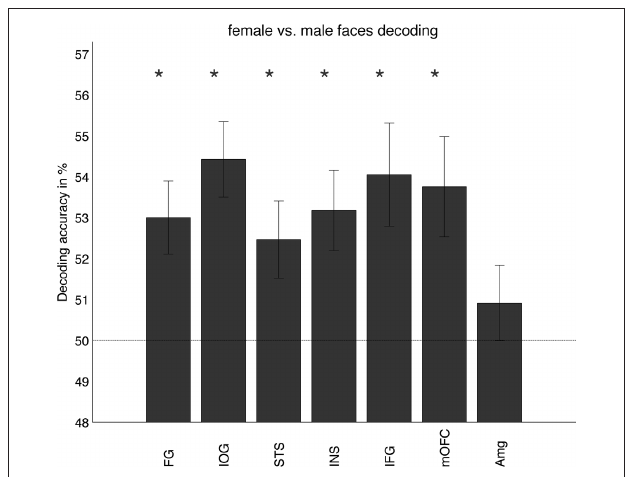
FIguRe A1 | Classification accuracies during the five facial-attractiveness rating runs. Note that the pattern of results across different areas is very similar to those in Figure 3